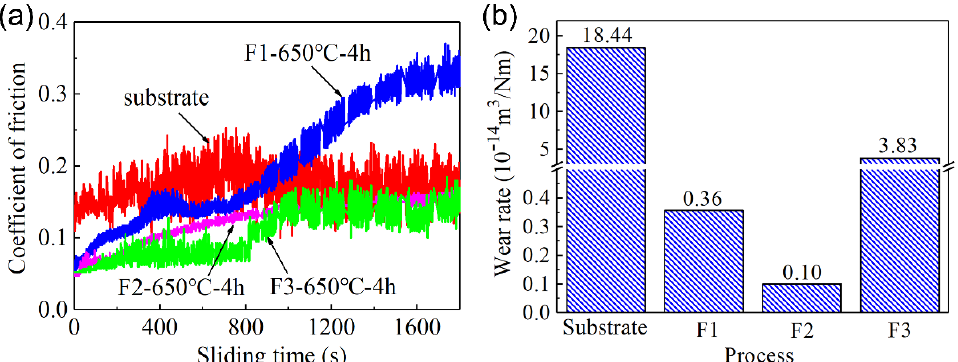
Figure 6. The friction coefficient and wear rate of C61900 Cu alloy and the modified surface: ( a ) friction coefficient, ( b ) wear rate.